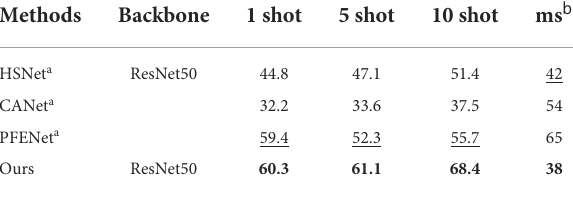
TABLE 1 Hand-Drill class mIoU and inference time (in ms) results on PST900 for multimodal few-shot learning.